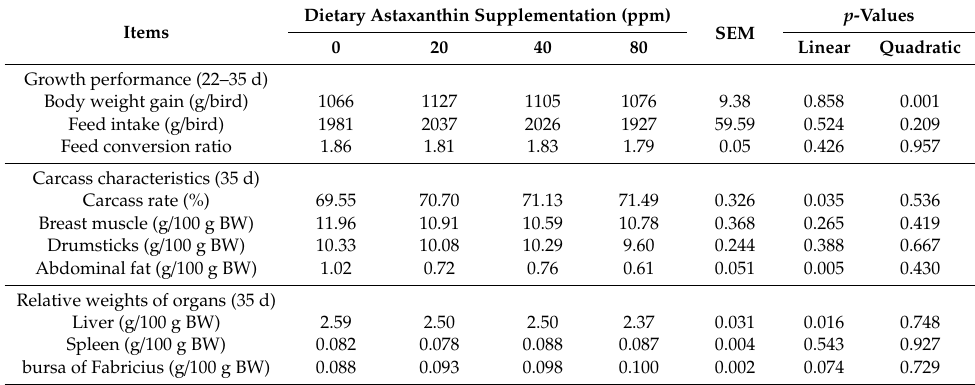
Table 3. Effect of dietary astaxanthin supplementation on carcass characteristics, relative weights of organs, and meat color of broiler under hot temperature.